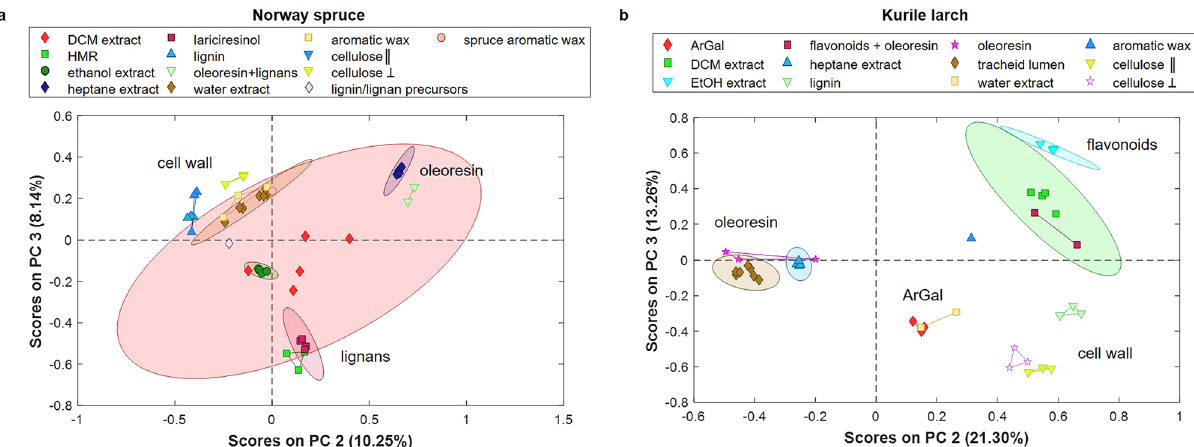
Figure 6. Sample scores of a principal component analysis performed on the MCR-ALS components and references of ( a ) Norway spruce and ( b ) Kurile larch. Principal components (PCs) 2 and 3 are shown; the rest can be viewed in the supplementary information Sect.